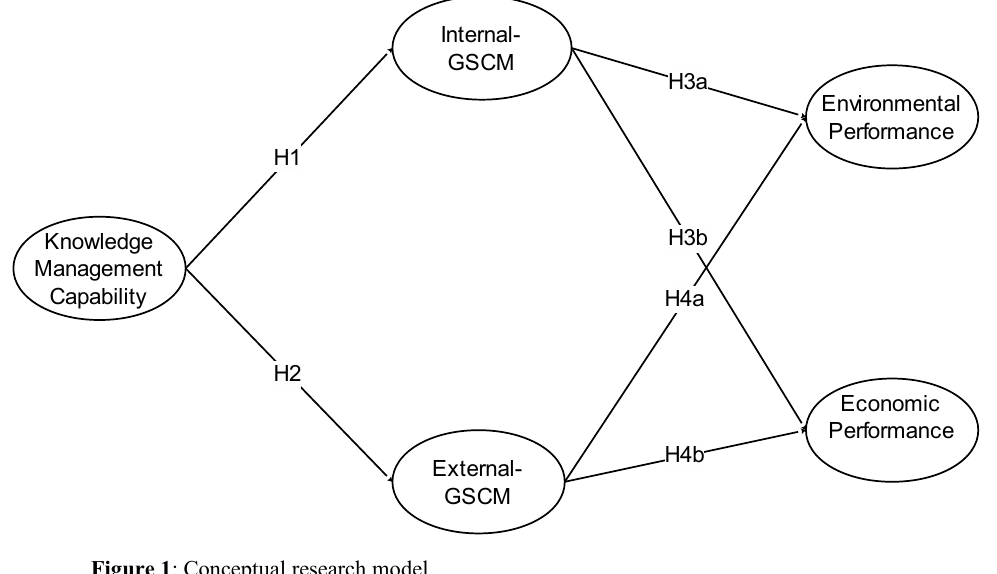
Figure 1 : Conceptual research